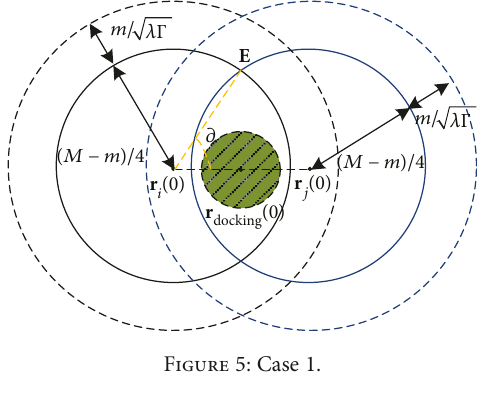
Figure 5: Case 1. Figure 6: Case